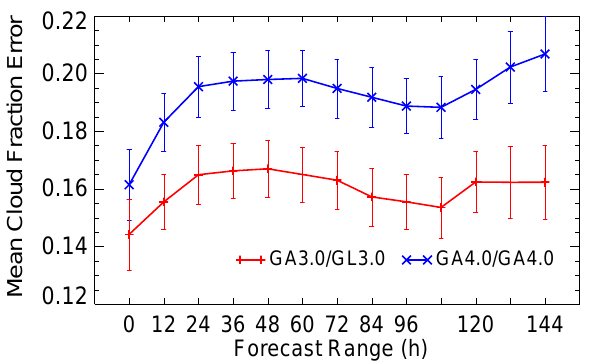
−1.0−0.5 −0.50.0 0.00.5 0.51.0 1.01.5 Fig. 13. Mean cloud cover forecast minus observation statistics as Fig. 13. Mean cloud cover forecast minus observation statistics as a function of forecast range (hours) a function of forecast range (hours) using a mixture of manual and using a mixture of manual and automatic surface observations in the North Atlantic/Europe region during Fig. 14. Profiles of mean temperature forecast minus observation automatic surface observations in the North Atlantic/Europe region Fig. 14. Profiles of mean temperature forecast minus observation statistics from 5 day forecasts using the January–February N 320-AL NWP trial. This covers a rectangular area in a rotated pole projection statistics from 5-day forecasts using all radiosonde observations in during the January–February N320-AL_NWP trial. This covers a all radiosondes observations in (a) the Northern Hemisphere verification area (20 ◦ –90 ◦ N) during the that in standard coordinates is bounded by the points (25.5 ◦ N, 37 ◦ W), (26.5 ◦ N, 30.5 ◦ E), (57 ◦ N, 61 ◦ E) (a) the Northern Hemisphere verification area (20 ◦ –90 ◦ N) during rectangular area in a rotated pole projection that in standard coordi- June–July N 320-AL NWP trial and (b) the Southern Hemisphere verification area (20 ◦ –90 ◦ S) during the June–July N320-AL_NWP trial and (b) the Southern Hemi- and (55.5 ◦ N, 67.5 ◦ W). nates is bounded by the points (25.5 ◦ N, 37 ◦ W), (26.5 ◦ N, 30.5 ◦ E), the January–February N 320-AL NWP trial. sphere verification area (20 ◦ –90 ◦ S) during the January–February (57 ◦ N, 61 ◦ E) and (55.5 ◦ N, 67.5 ◦ W). N320-AL_NWP